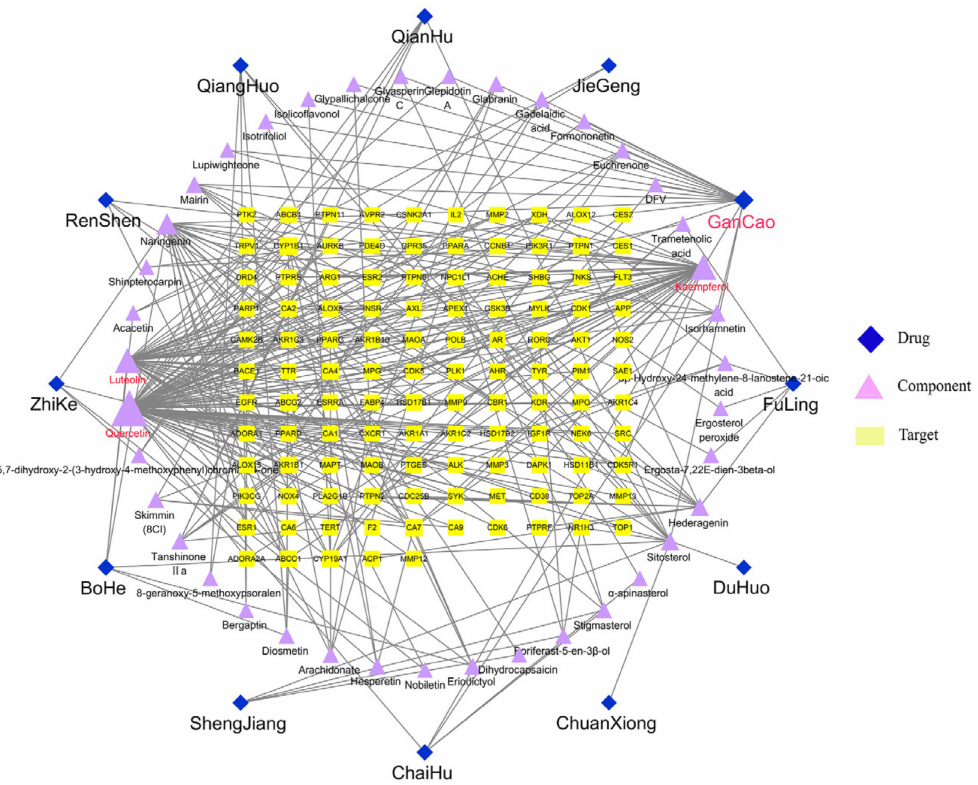
Figure 2. The drug–ingredient–target network for RSBDP in the treatment of IBD. The dark blue diamond the drug; the light purple triangle the pharmaceutical ingredients; the yellow rectangle the potential targets. Node size represents degree